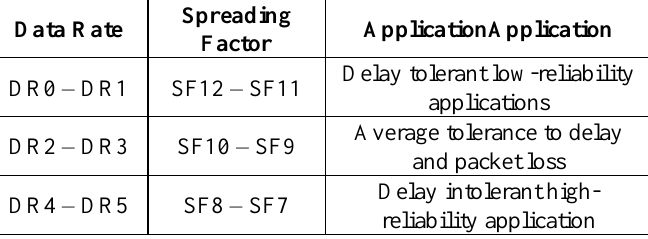
Table 1: Heterogeneous Network Data Rate Allocation.